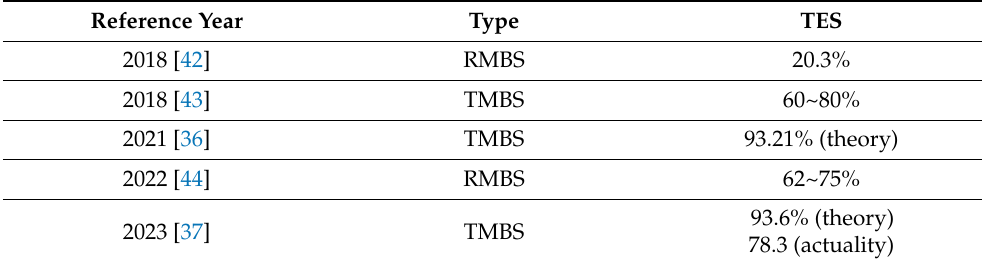
Table 2. Some data for the total splitting efficiency of previous